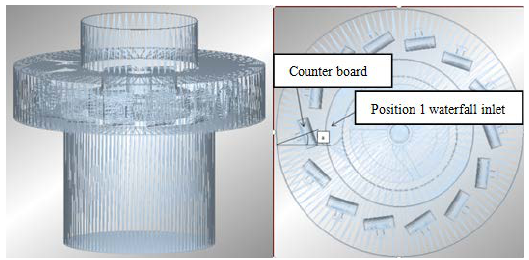
Fig. 12 Diagram of counter boards